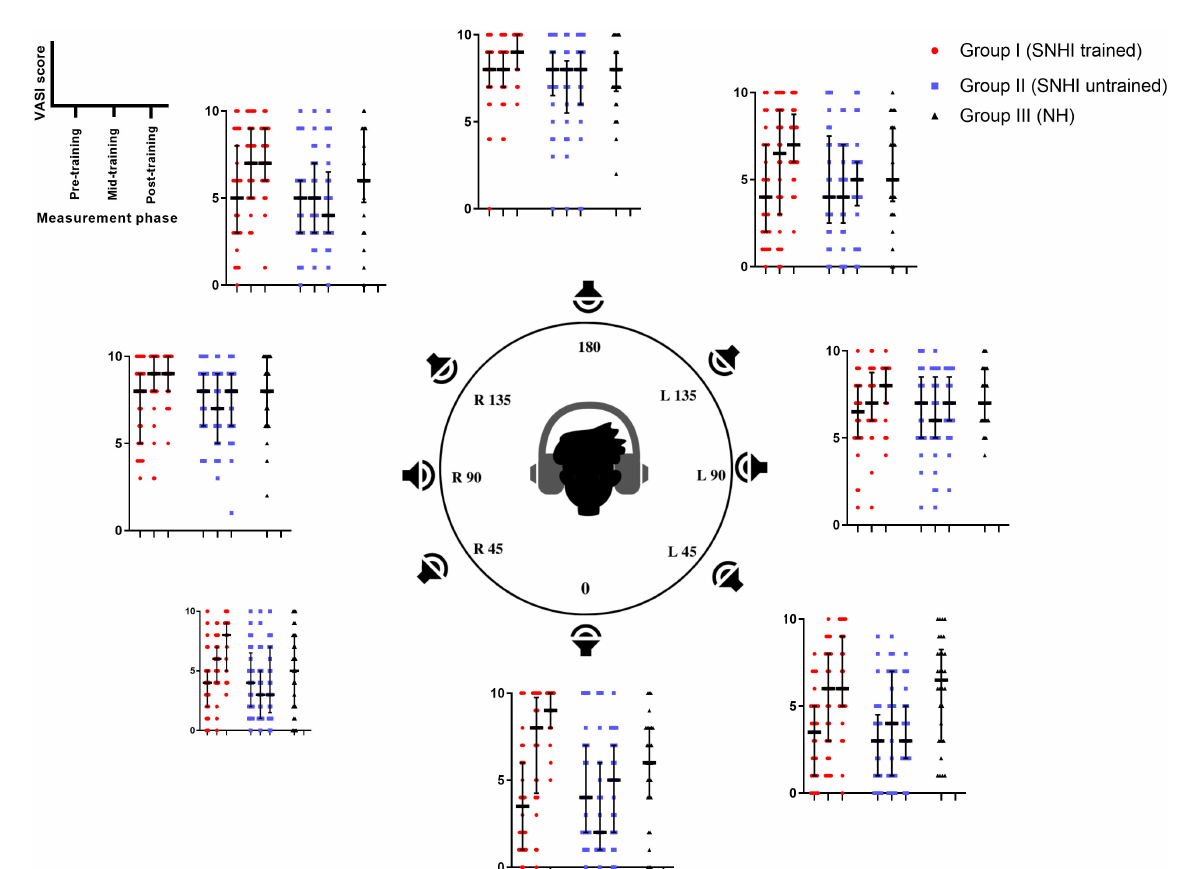
FIGURE6 Comparison of VASI scores of group I (SNHI-trained) and group II (SNHI-untrained) participants as a function of VAST across in virtual location. The inner dummy head panel represents eight VAS locations used in the study, while the outer panels denote VASI scores of each participant corresponding to VAS location mentioned in the inner panel at three evaluation phases (pre-, mid-, and post-training). The horizontal line in each box plot at center represents the median, while the “ + ” sign indicates the mean for each test. The box area corresponds to interquartile range, while the error bar indicates interquartile deviation. The VASI of group III (NH listeners) is given only for comparison purpose. Maximum score per location is